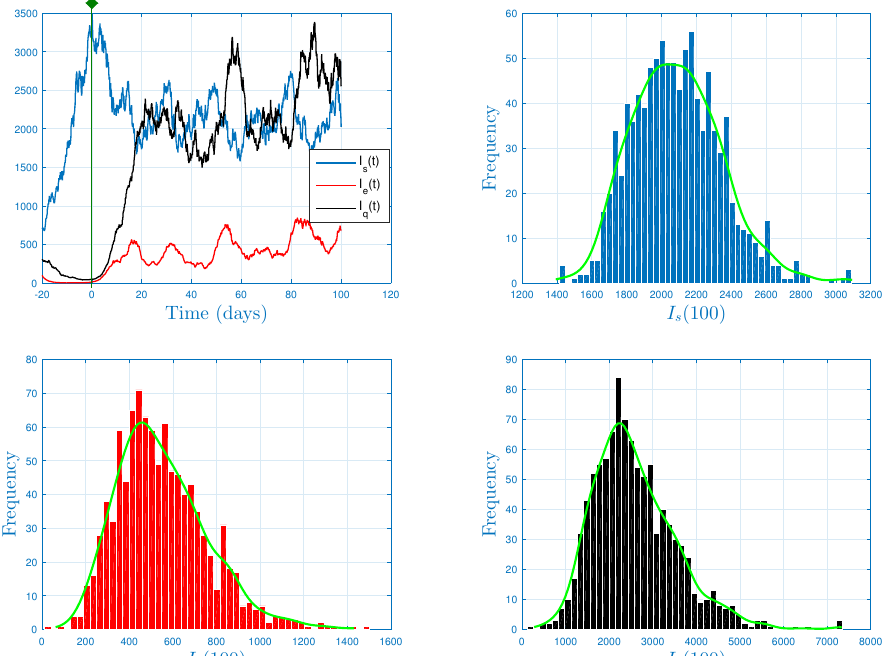
Figure 3. Solutions’ paths and the associated histograms of the Ebola virus model (3) when the numerical values are taken as shown in Table 2 and the random intensities as follows: (cid:118) s = 0.8, (cid:118) e = 2.19, (cid:118) q = 0.44 and (cid:118) r = 0.3.